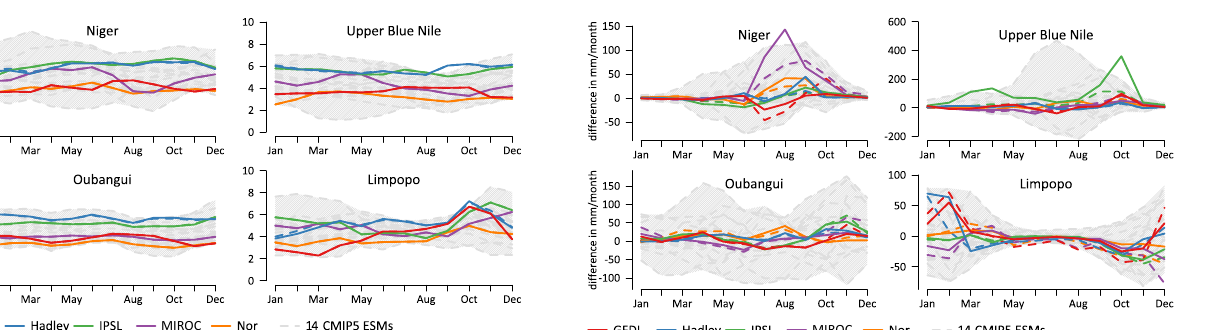
Fig. 6. Difference in monthly precipitation in the far projection pe- riod (2070–2099) relative to the base period (1970–1999) for RCP 8.5 for five bias corrected model projections (coloured lines), the uncorrected ESMs (coloured dashed lines) and 14 ENSEMBLE ESMs (grey dashed